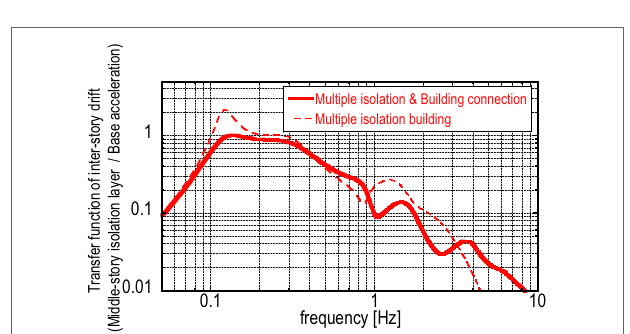
FIGURE 4 | Transfer function of inter-story drift (middle-story isolation layer/base acceleration) .